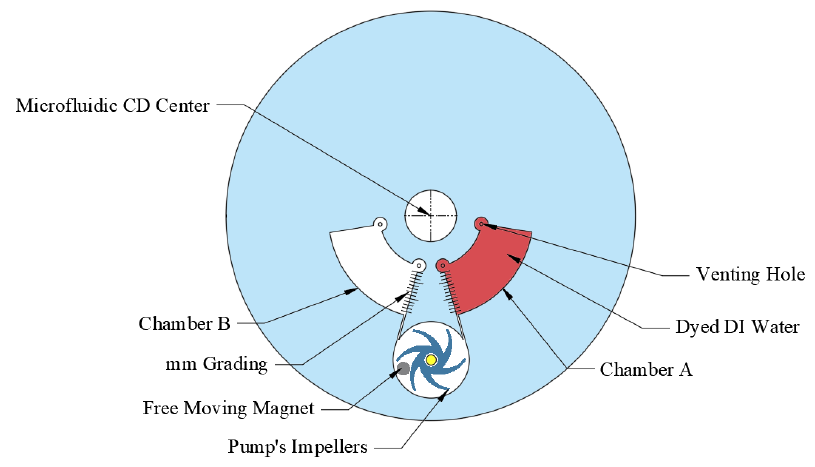
Figure 6. Microfluidic design and experiment for bidirectional pumping.